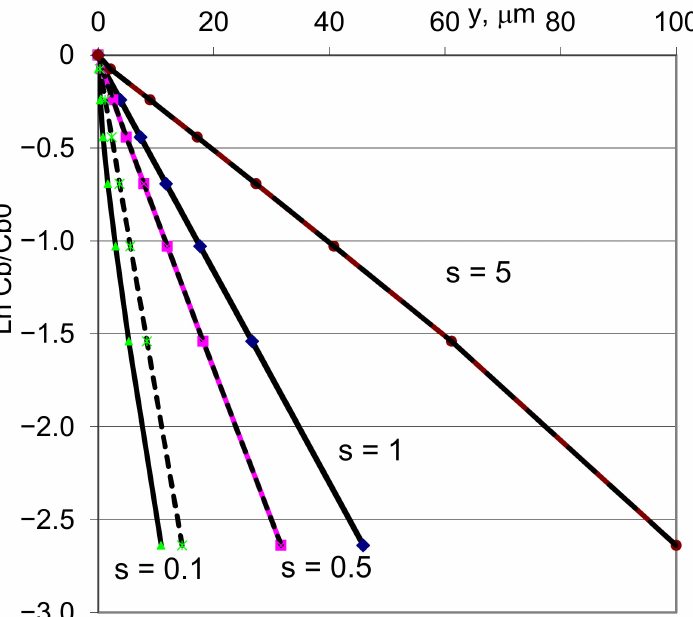
Figure 3. Modelling of GB diffusion profile with diffusion parameters corresponding to Cu self- diffusion at 550 ◦ C, C b 0 = 0.1. Enrichment coefficient is variable parameter (according